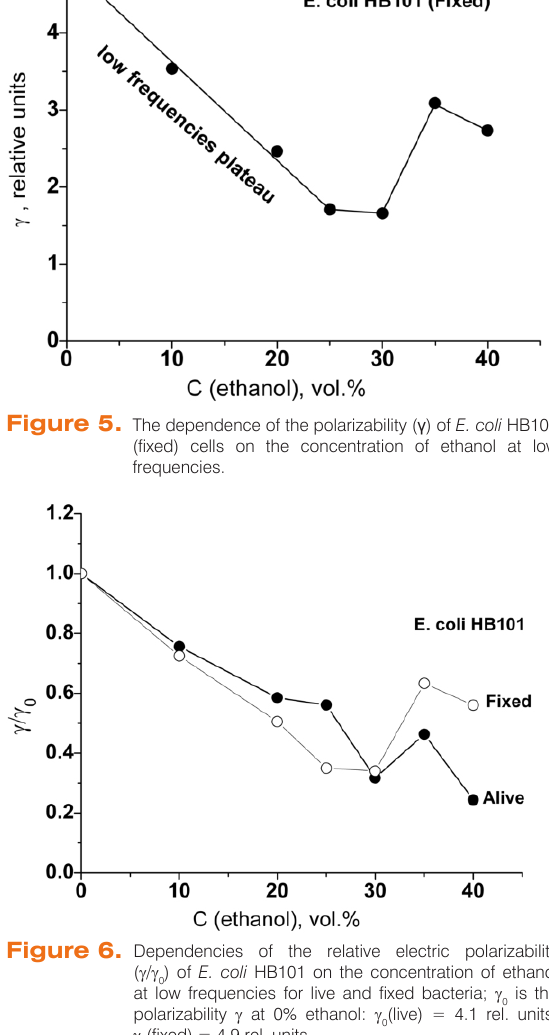
is the 0 (live) = 4.1 rel. units, 0